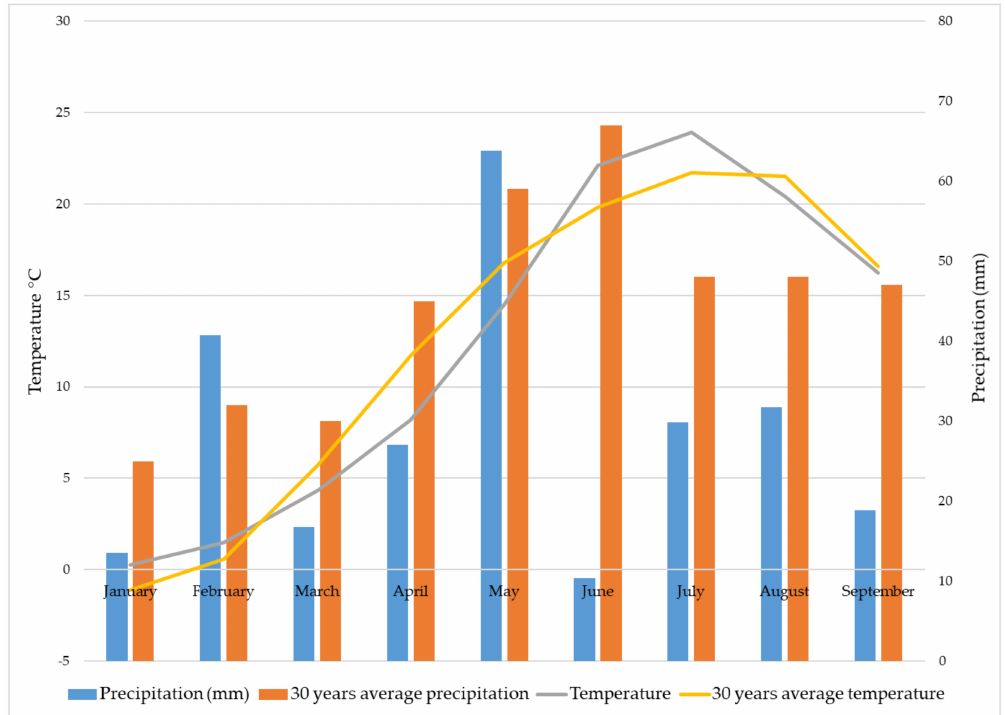
Figure 2. Monthly average air temperatures and monthly precipitation totals compared to 30-year average. The 30-year average: monthly average values for the last 30 years at the experiment site (Debrecen-L á t ó k é p,